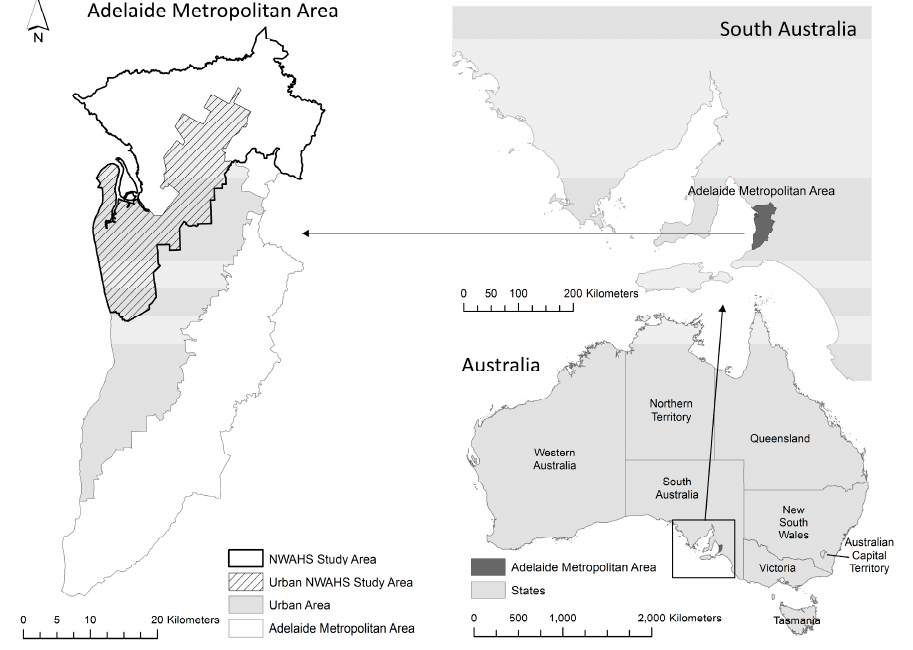
Figure 1. Study area—urban northern and western regions of Adelaide. NWAHS: North West Adelaide Health Study.